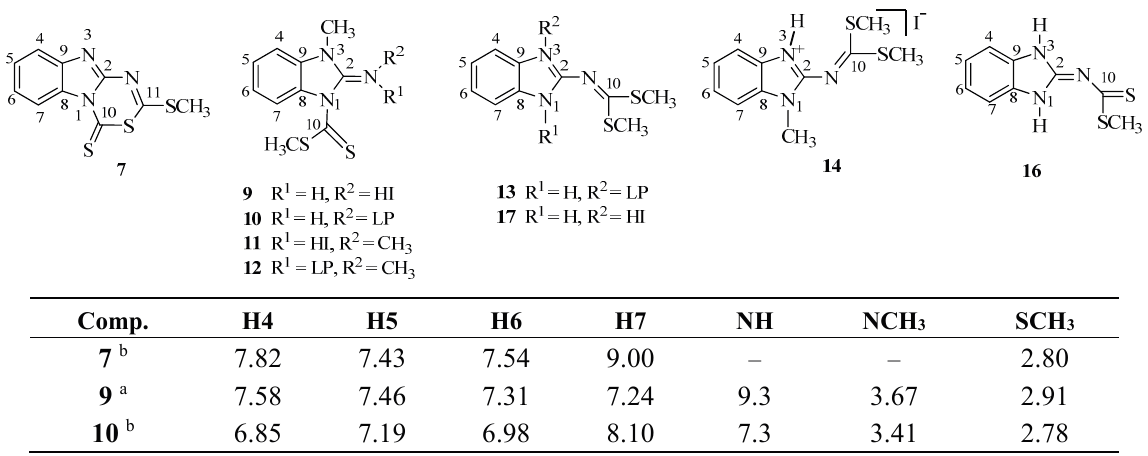
Table 1. 1 H-NMR chemical shifts of compounds 7 , 9 – 14 , 16 and 17